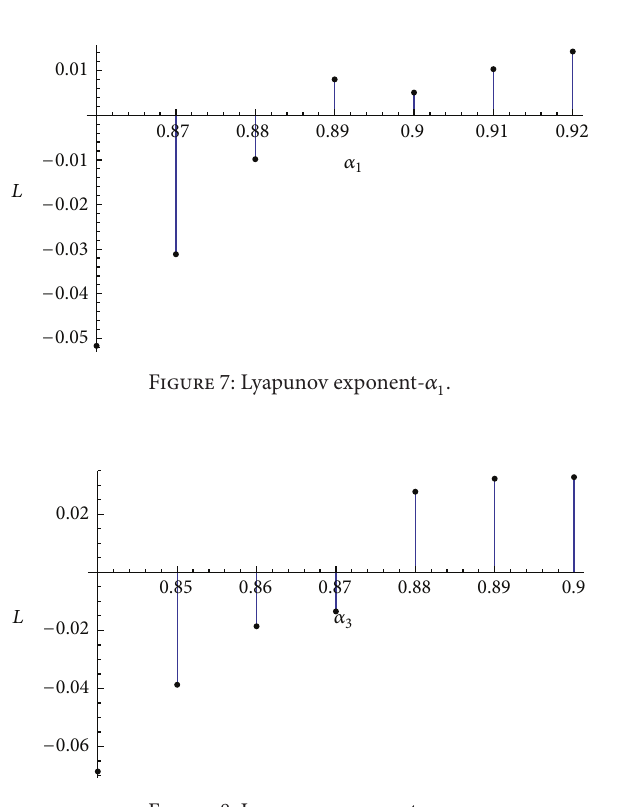
Figure 12: Phase portrait y - z 𝛼 3 = 0.88, 𝛼 2 = 𝛼 1 = 1